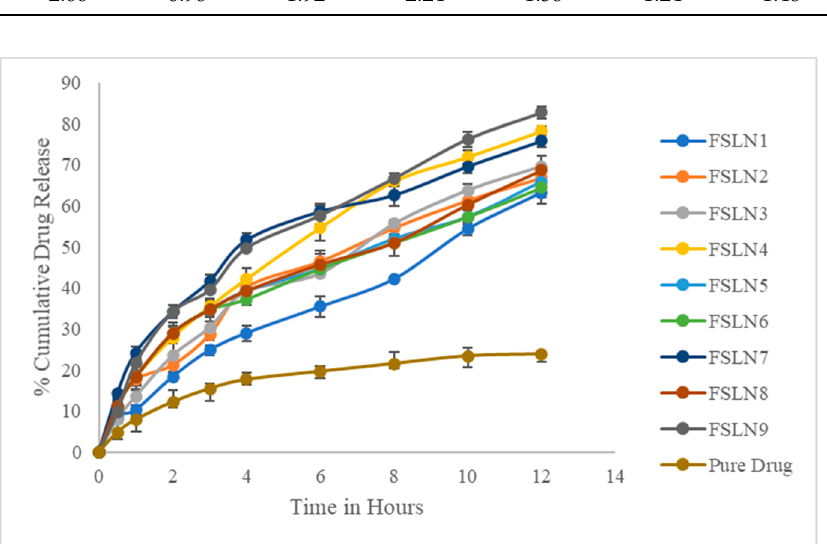
Figure 2. Cumulative percent drug release of all formulation (Error bars indicated standard deviation of 6 determinations).